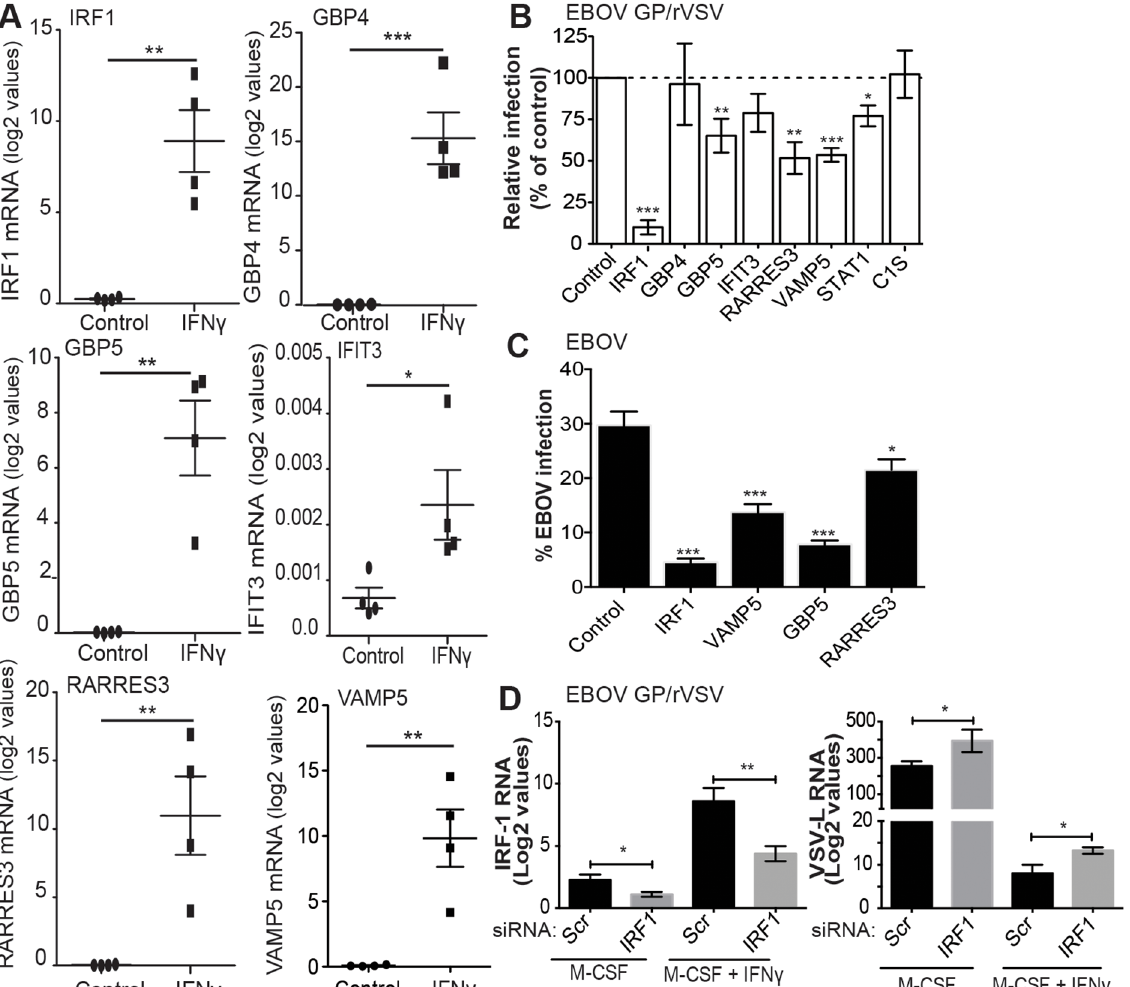
Fig 4. Identification of IFN γ -stimulated genes that inhibit EBOV infection. (A) mRNA validation of hMDM profiling results for several of the top IFN γ - stimulated genes identified in our gene arrays. RNA obtained for the microarray analysis was assessed for mRNA levels of the selected genes by qRT-PCR. Results are represented as the log2 values. (B) Identification of IFN γ -stimulated genes that inhibit EBOV GP/rVSV infection. Highly permissive HEK 293T cells stably expressing TIM -1 (H3 cells) were infected with EBOV GP/rVSV 48 hours following transfection of 2 μ g of ISG-RFP lentiviral constructs. Cells gated for RFP expression were assessed for EBOV GP/rVSV infection by detection of GFP. Shown is infection of EBOV GP/rVSV in ISG expressing cells relative to infection of cells transfected with a fluc-RFP expressing lentivirus (control). (C) Novel ISGs that inhibit EBOV GP/rVSV also block EBOV infection. HeLa cells were infected with EBOV 48 hours following electroporation of 5 μ g of ISG-RFP lentiviral constructs. Infection was assessed by microscopy 24 hours later and percent of cells that were GFP positive were calculated by CellProfiler image analysis software. A lentiviral construct expressing IRF1 served as a positive control in these studies. (D) IRF1 knock down increases EBOV GP/rVSV infection following IFN γ stimulation. IRF1 or scrambled (Scr) siRNA were loaded into HEK 293T derived exosomes. SiRNA loaded exosomes (2.5 μ g) were delivered and IFN γ added to BALB/c IFNAR -/- peritoneal macrophages 24 hours prior to EBOV GP/rVSV infection (MOI = 0.1). Twenty-four hours following infection, total RNA was isolated from the macrophages. Amount of IRF1 expression and infection (by detection of VSV polymerase (L)) was quantified by qRT-PCR. Results represent the means ± s.e.m. Significance was determined by Student ’ s t-test analysis, * p < 0.05, ** p < 0.01, *** p <